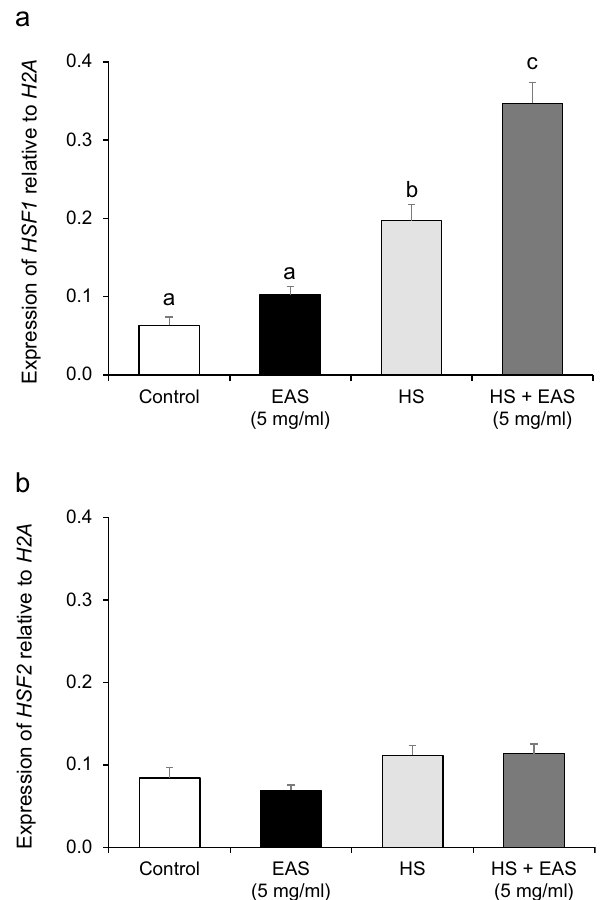
Figure 4. Effect of EAS on the expression of HSF1 and HSF2 in bovine CG cells under non- and HS conditions. Cells were treated for 6 h with or without EAS (5 mg/ml) under normal conditions at 38.5 °C (control, EAS group) and HS conditions at 41 °C (HS, HS + EAS group). The expression levels of ( a ) HSF 1 and ( b ) HSF2 were examined using real-time quantitative PCR normalized to H2AFZ as a reference gene. Data are shown as the mean ± SEM, n = 5, a vs. b ( P < 0.05), a vs. c ( P < 0.01), and b vs. c ( P <